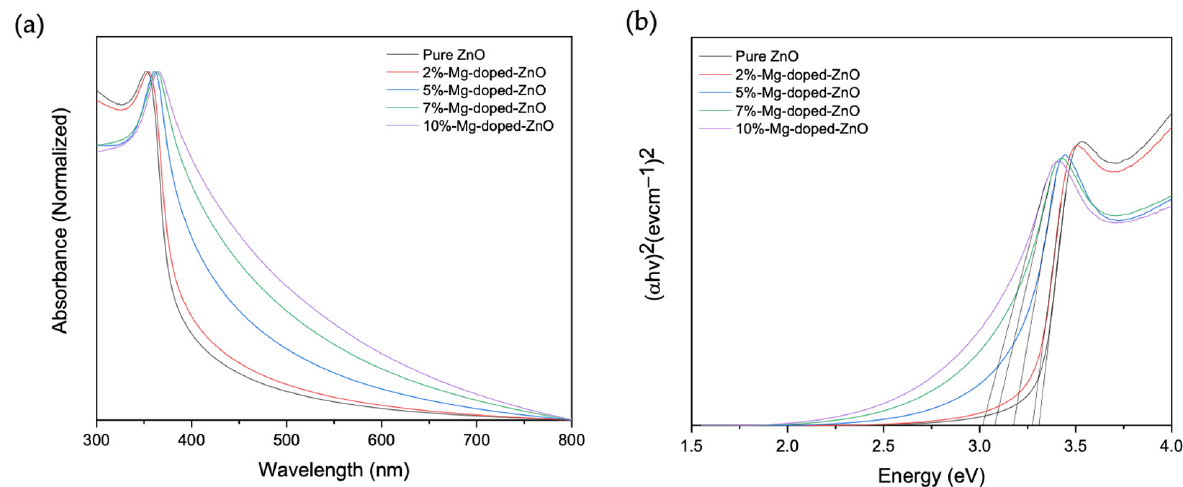
Figure 3. ( a ) Normalized absorbance spectra of pure and ZnO nanostructures; ( b ) Tauc’s plot showing bandgap values, which were obtained by extrapolating the linear portions of the plot and are depicted as black lines.